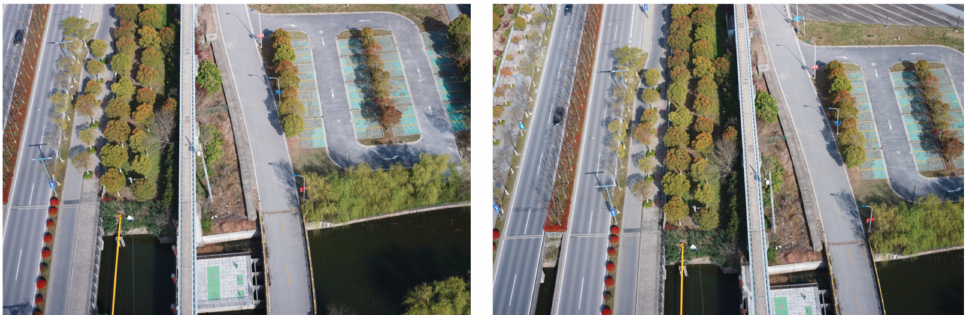
Figure 1. Two randomly selected magnetic levitation image data as seed images. Building the Gaussian difference pyramid